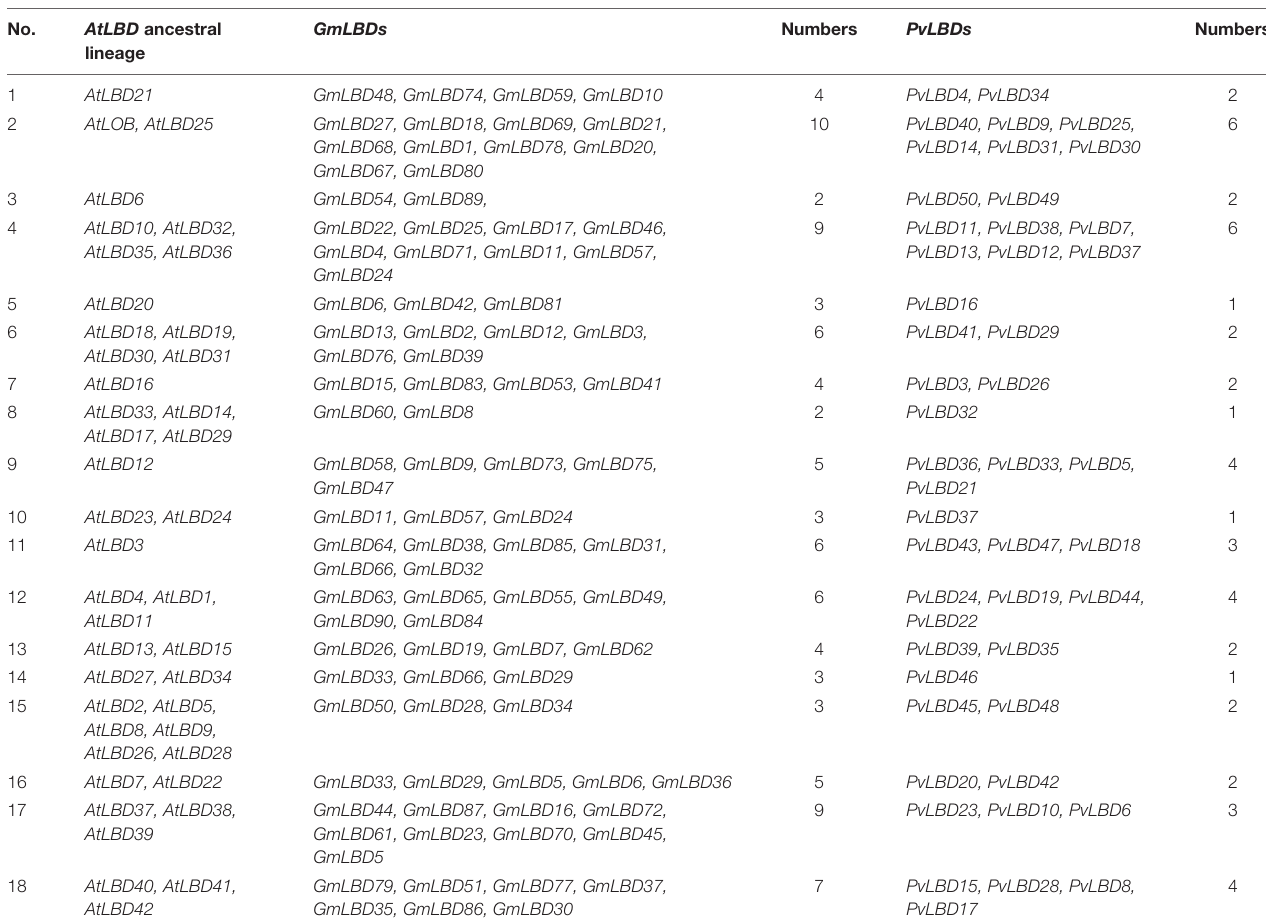
TABLE 2 | Summary of GmLBDs and PvLBDs presented in 18 AtLBD ancestral lineages.